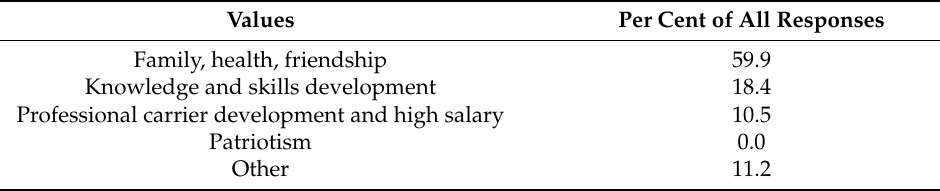
Table 1. The Values of analysed Gen Z representatives.